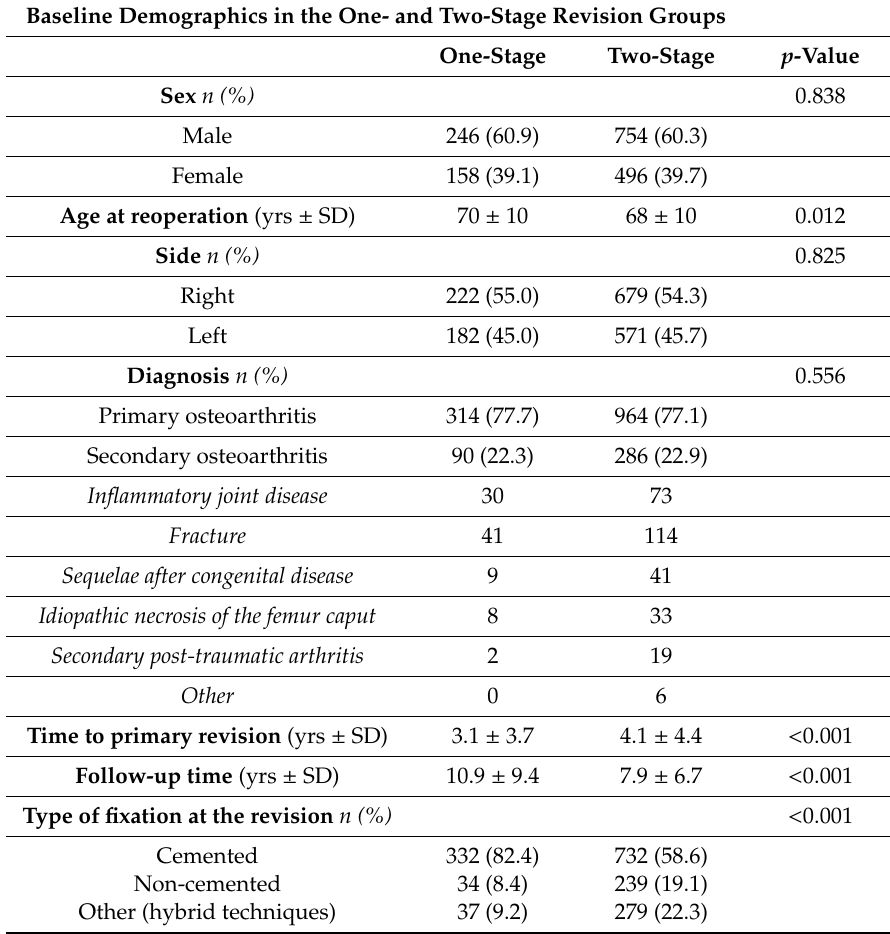
Table 1. The demographics of the one-and two-stage revision